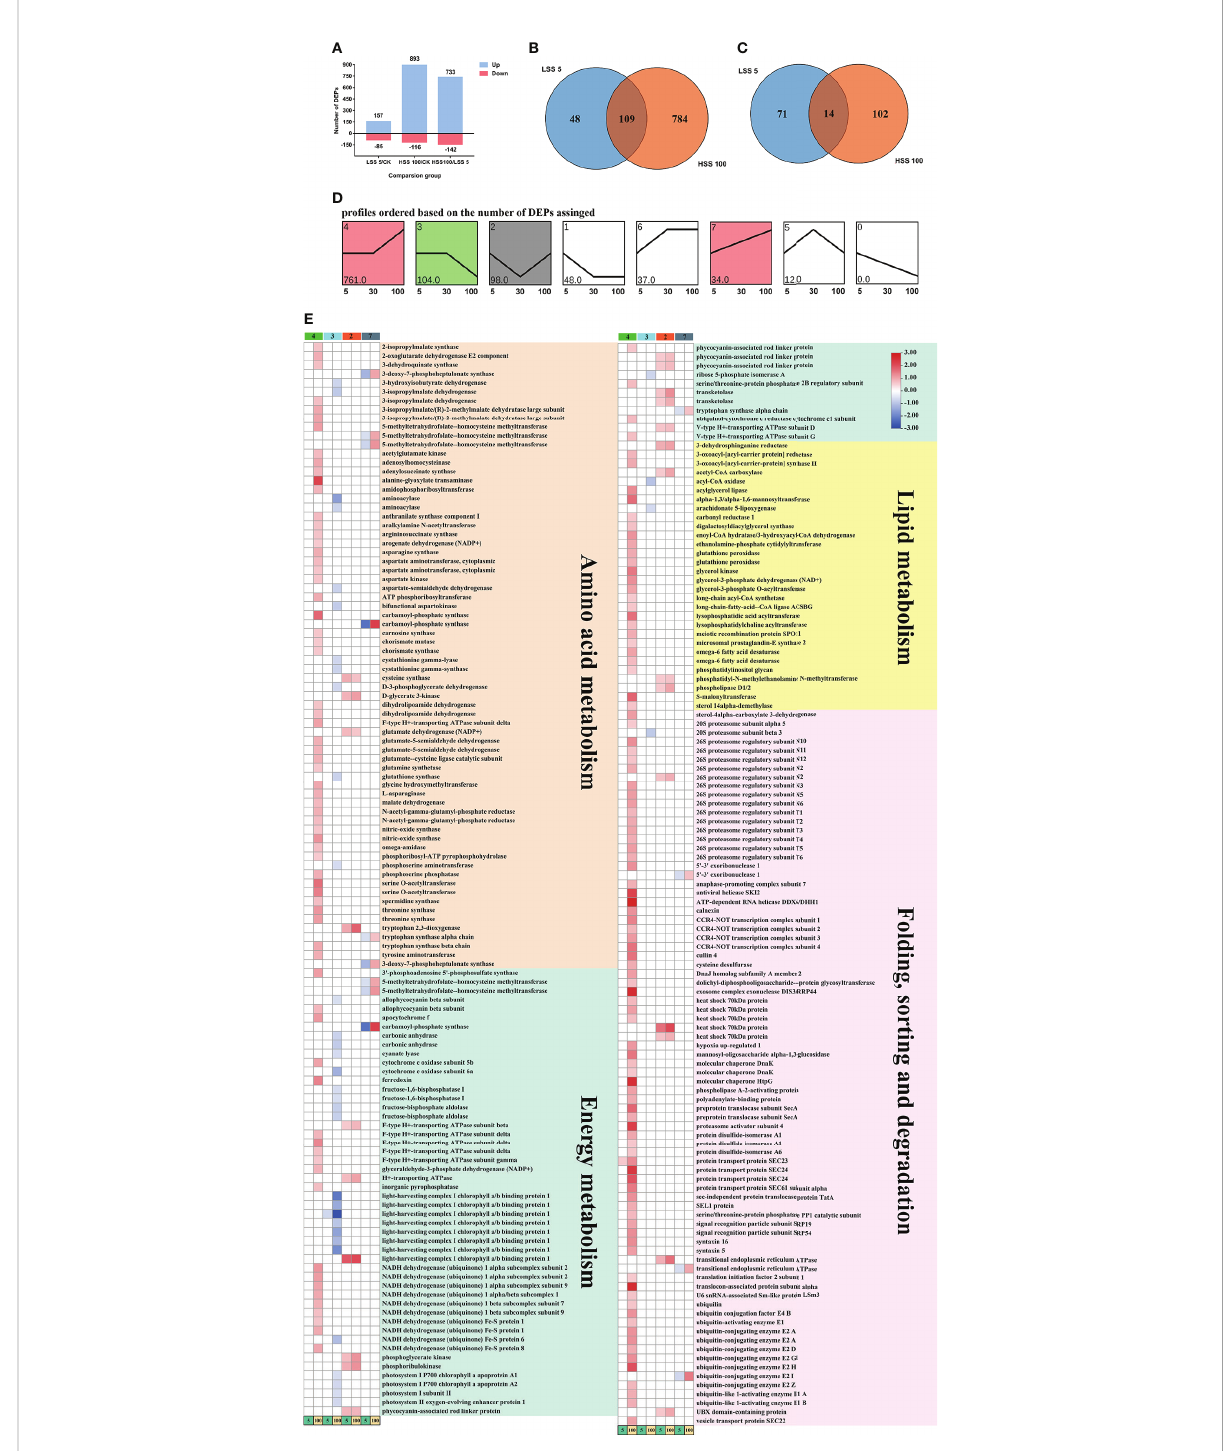
FIGURE 4 Analysis of DEPs in P. haitanensis exposed to hypersaline and hyposaline treatments for 4 h. (A) Number of DEPs in each comparison. (B) Venn diagram of DEPs (increased abundance). (C) Venn diagram of DEPs (decreased abundance). (D) The expression patterns of 1,094 proteins analyzed by model pro fi le. The expression patterns of 1,094 proteins were analyzed and eight model pro fi les were used to summarize the data. Each box represents a model expression pro fi le. The upper number in the pro fi le box is the model pro fi le number and the lower one is the number of proteins contained; four expression patterns showed signi fi cant P values (colored boxes, FC ≥ 1.5 and P < 0.05). (E) Effects of hypersaline and hyposaline treatments on amino acid synthesis, energy metabolism, FA synthesis, protein synthesis and processing of P. haitanensis (Pro fi le 4: green; Pro fi le 3: blue; Pro fi le 2: red; Pro fi le 7: